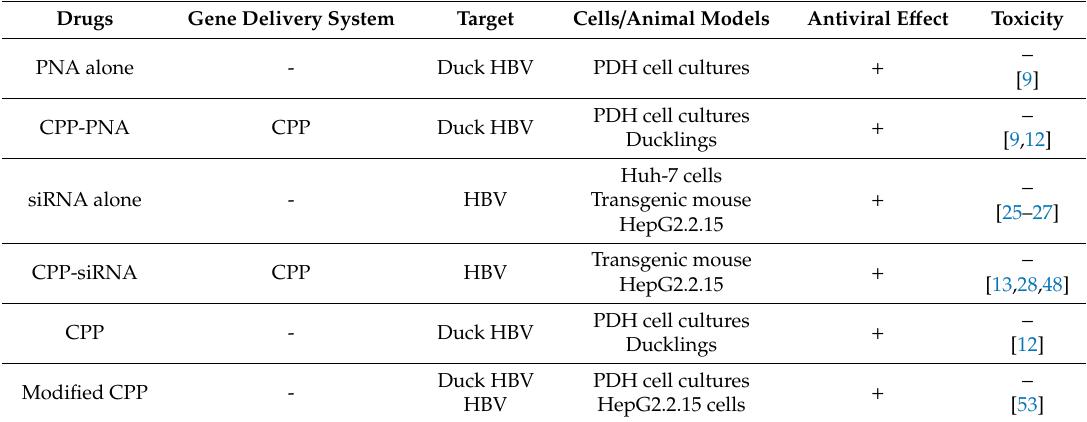
Table 1. Di ff erent therapeutic drugs and their biological activities against hepatitis B